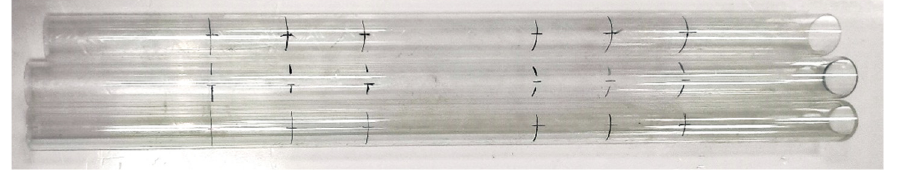
Figure 1. Acrylic pipes used in the test. The wall thickness is 1 mm, 2 mm, and 3 mm from top to bottom respectively.